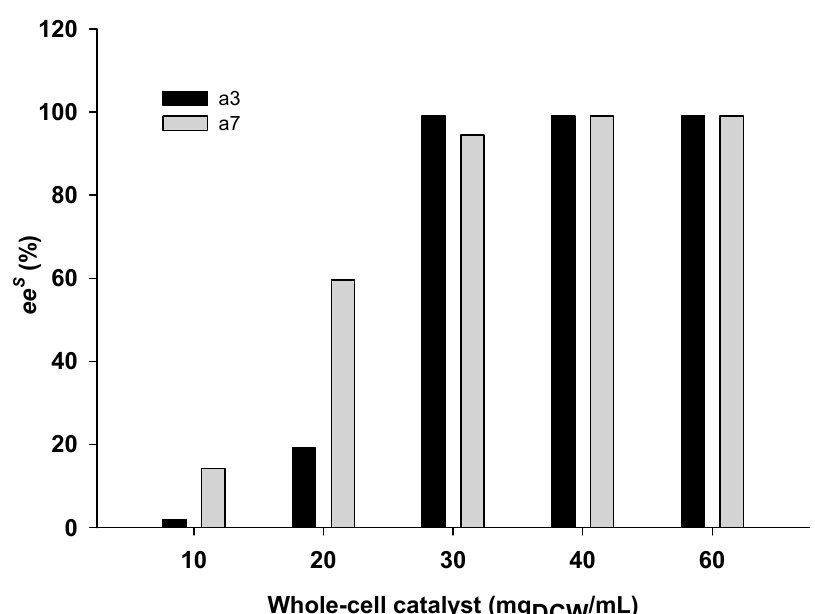
Figure 8. Effect of concentration of whole-cell catalyst on the kinetic resolution of 100 mM rac- a3 and rac- a7 . Reaction conditions: (100 mM rac- a3 or rac- a7 , 200 mM Pyruvate), 100 mM glycine buffer pH Table 1. Kinetic resolution of various racemic amines. Substrate Conv. (%) [a]